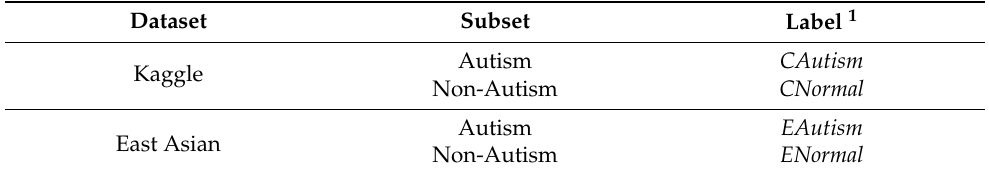
Table 3. Results for deep learning feasibility experiment with Orange platform and East Asian da- taset.